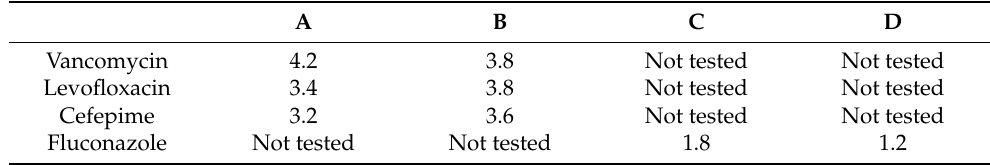
Table 5. Antimicrobial activity of control